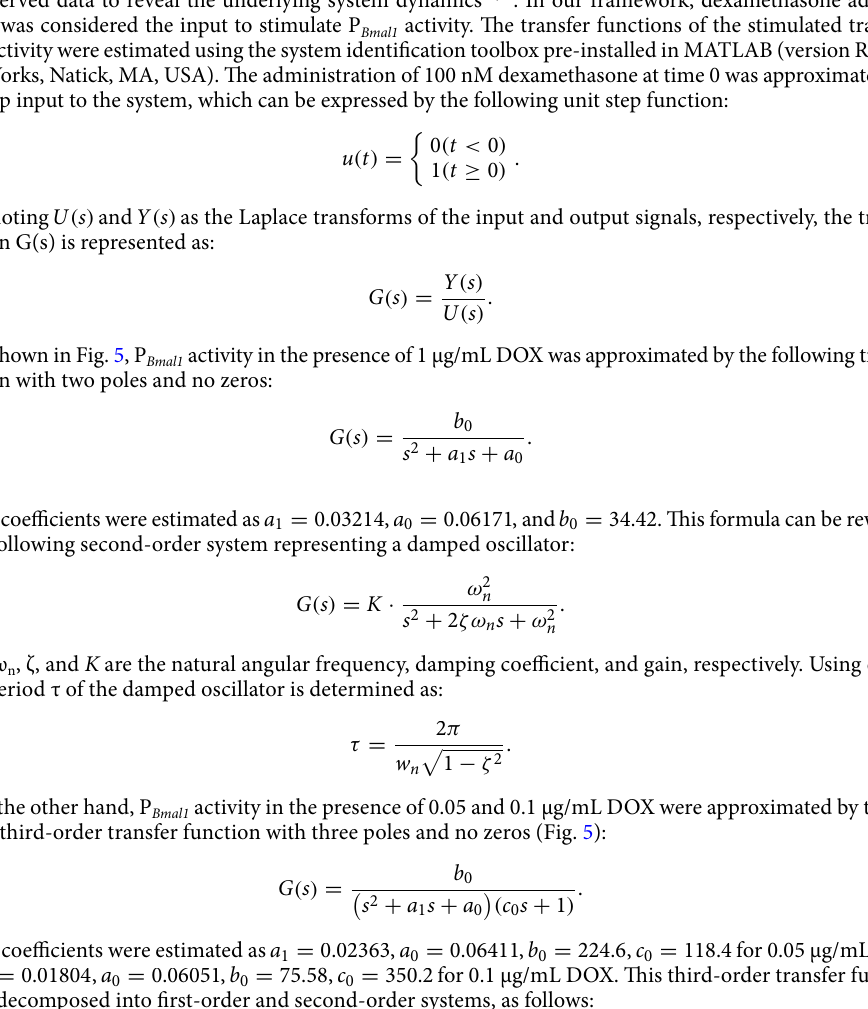
Figure 4. Accumulation of REV-ERBα and CLOCK does not show obvious circadian rhythmicity. ( A ) A mixture of equal amounts of protein samples collected from U2OS-P Bmal1 :: Fluc /ΔBmal1/P TRE3Gs ::Myc-Bmal1 strain-2 cell cultures from 0 to 52 h after the addition of 100 nM dexamethasone in the presence of each doxycycline (DOX) concentration was subjected to immunoblot analysis using anti-REV-ERBα antibodies. The amount of protein was calculated by the density of each band versus total protein and were normalized using the value from the 1 µg/mL DOX group. The results are shown as mean ± SEM (N = 3). Different characters (a, b) indicate significant differences (one-way ANOVA followed by Tukey’s multiple comparison test, P < 0.05). ( B – E ) Time course of protein expression in the presence of 0.1 µg/mL ( B , D ) and 1 µg/mL DOX ( C , E ). Images showing the protein bands detected for REV-ERBα ( B – C ), CLOCK ( D – E ), and total protein (TP) stains (upper panels). Asterisks in ( B , C , E ) indicate nonspecific bands. Markers (filled traingle, filled diamond, and filled circle) indicate three biological replicates. For REV-ERBα detection, the same blots used for MYC-BMAL1 detection were reprobed. The protein amount was quantified using densitometry (lower panel). The relative expression of REV-ERBα ( B – C ) and CLOCK ( D – E ) protein was calculated by the density of each band vs. total protein and were normalized against the intensity of pooled 0 to 52 h samples. Black lines indicate the average values of three biological replicates. No significant rhythmicity was detected for REV-ERBα at 0.1 and 1 µg/mL DOX (JTK cycle test, ADJ. P = 1) or CLOCK at 0.1 µg/mL DOX (JTK cycle test, ADJ. P = 0.77). CLOCK at 1.0 µg/ mL DOX exhibited significant rhythmicity (JTK cycle test, ADJ. P = 0.029) with low amplitude (JTK cycle test, AMP =